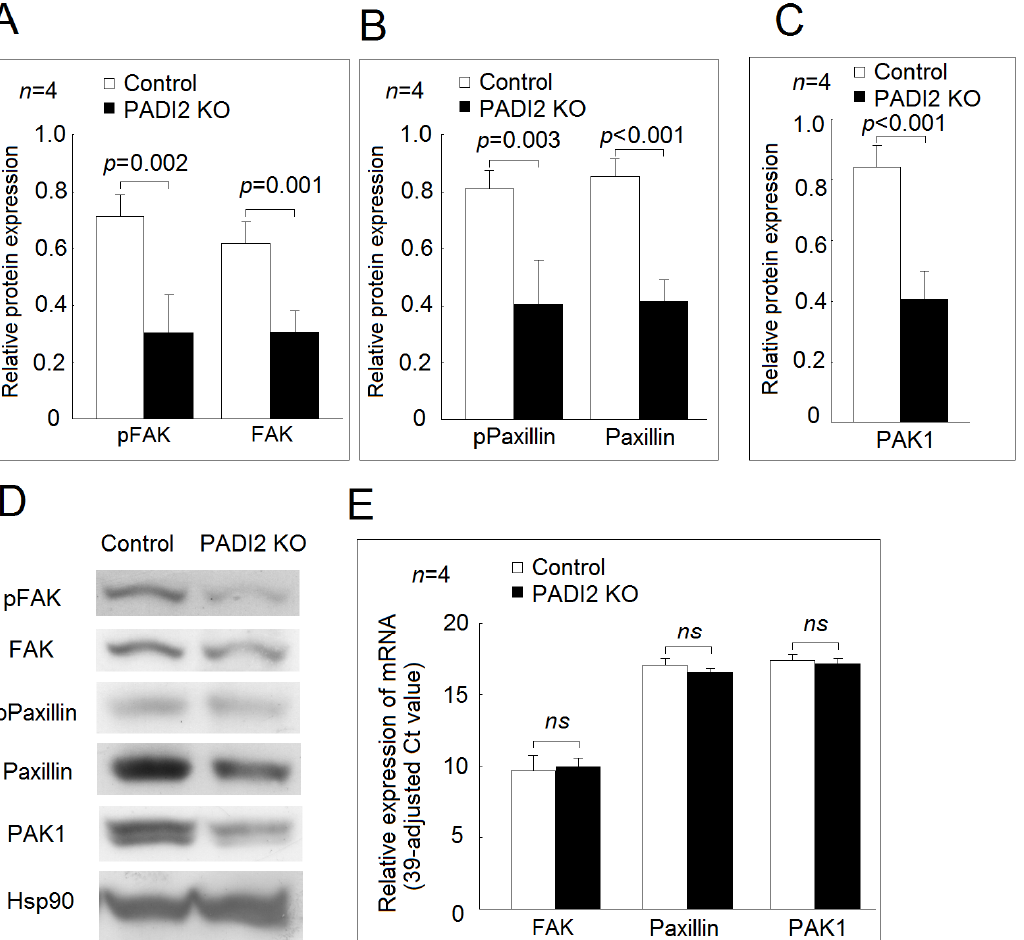
Figure 5. Effects of PADI2 knockout in the protein and mRNA expression of focal adhesion kinase ( FAK ) , paxillin, and PAK1 in the U937 cells: ( A ) comparison of the relative protein expression levels of FAK and phospho-FAK in the PADI2 knockout group and the control group; ( B ) comparison of the relative protein expression levels of paxillin and phospho-paxillin in the PADI2 knockout group and the control group; ( C ) comparison of the relative protein expression levels of PAK1 in the PADI2 knockout group and the control group; and ( D ) Representative images showing the relative protein expression levels of FAK, paxillin, and PAK1 in the PADI2 knockout group and the control group; ( E ) the relative mRNA expression levels of FAK, paxillin , and PAK1 in the U937 cells. In the U937 cells, the protein expression levels of the cell adhesion-related proteins, including FAK, phospho-FAK, paxillin, phospho-paxillin, and PAK1, were performed by Western blotting in the PADI2 knockout group and the control group. The relative protein expression was defined as the ratio of specific protein/hsp90 band intensity.